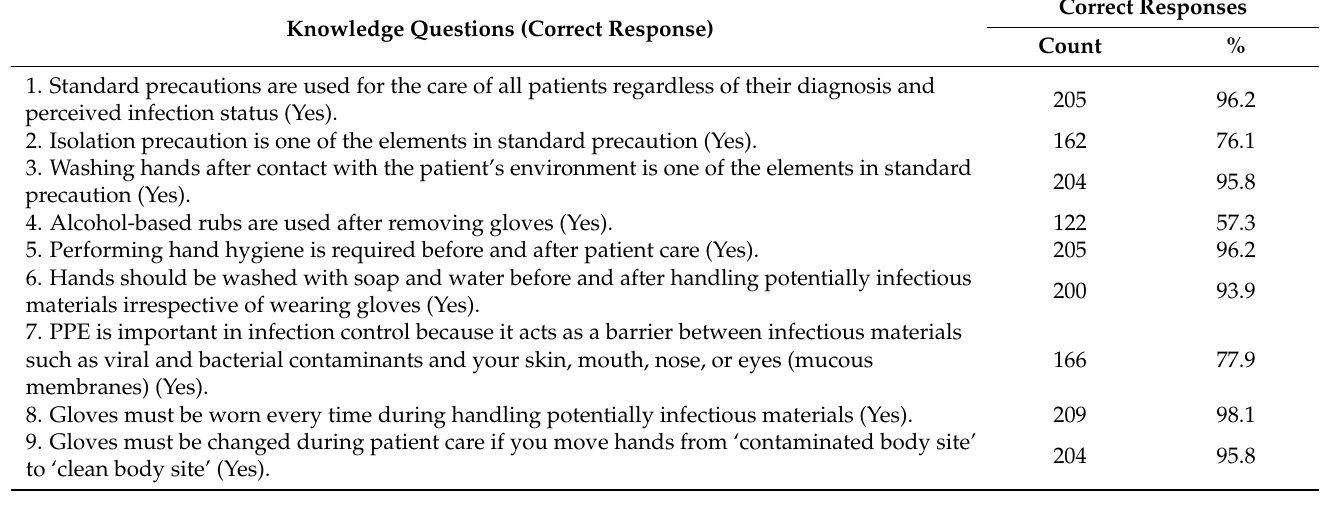
Table 2. Knowledge of HCWs on infection control standard precautions, Qassim University Hospital,